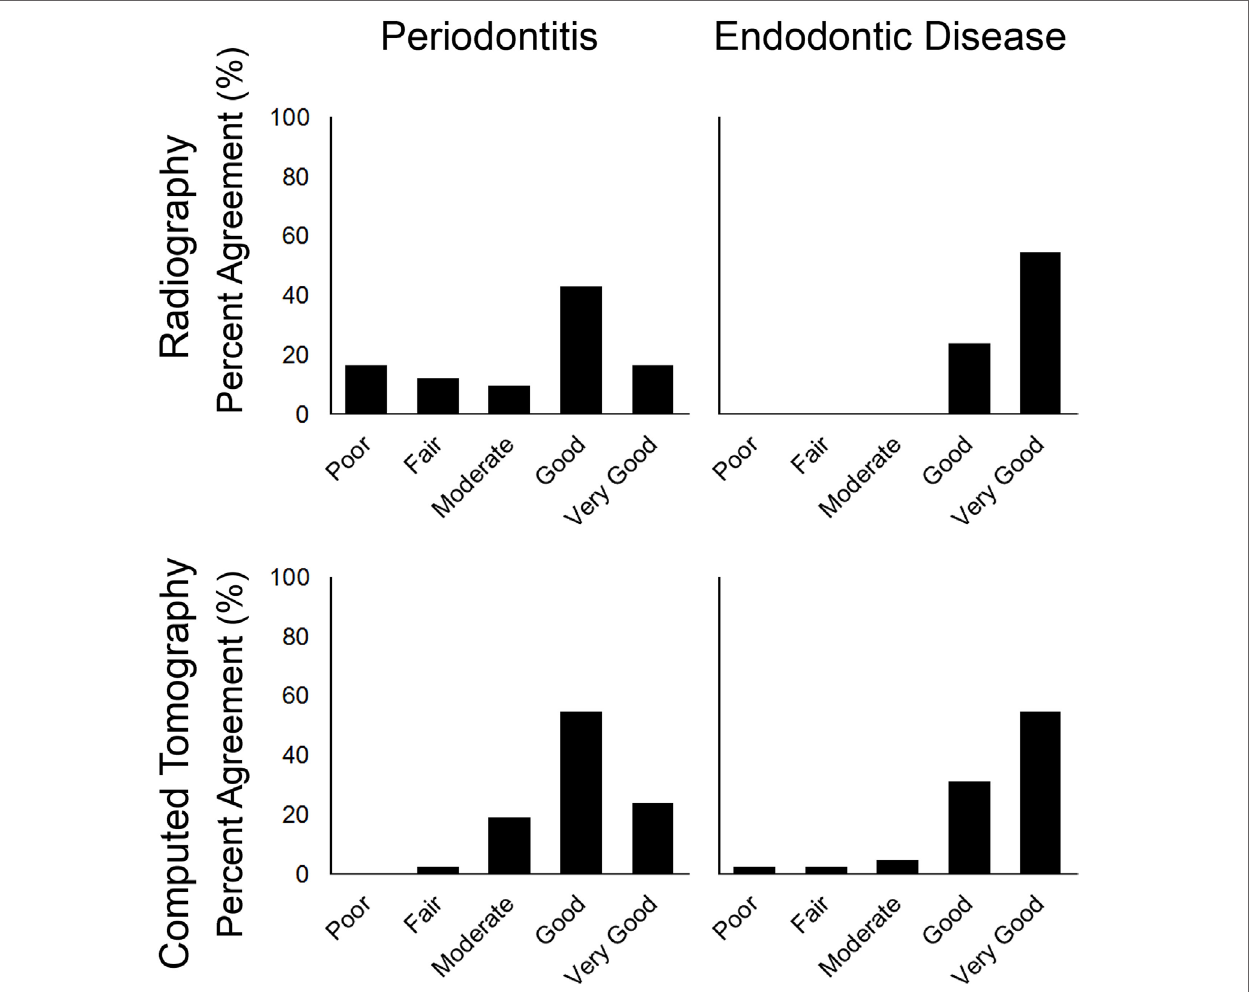
FigUre 4 | Bar chart showing percentage of agreement between observers by intraoral radiography and cT for periodontitis and endodontic disease for the entire oral cavity